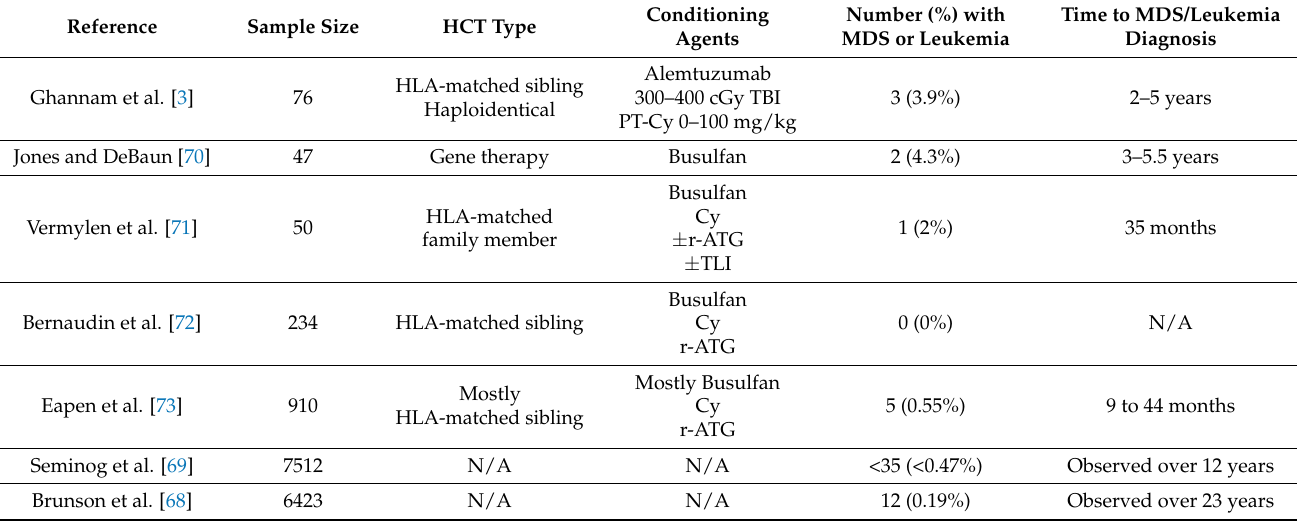
Table 1. Percentage of Patients Reported with Myelodysplastic Syndrome or Leukemia in Individuals with Sickle Cell Disease with and without Curative